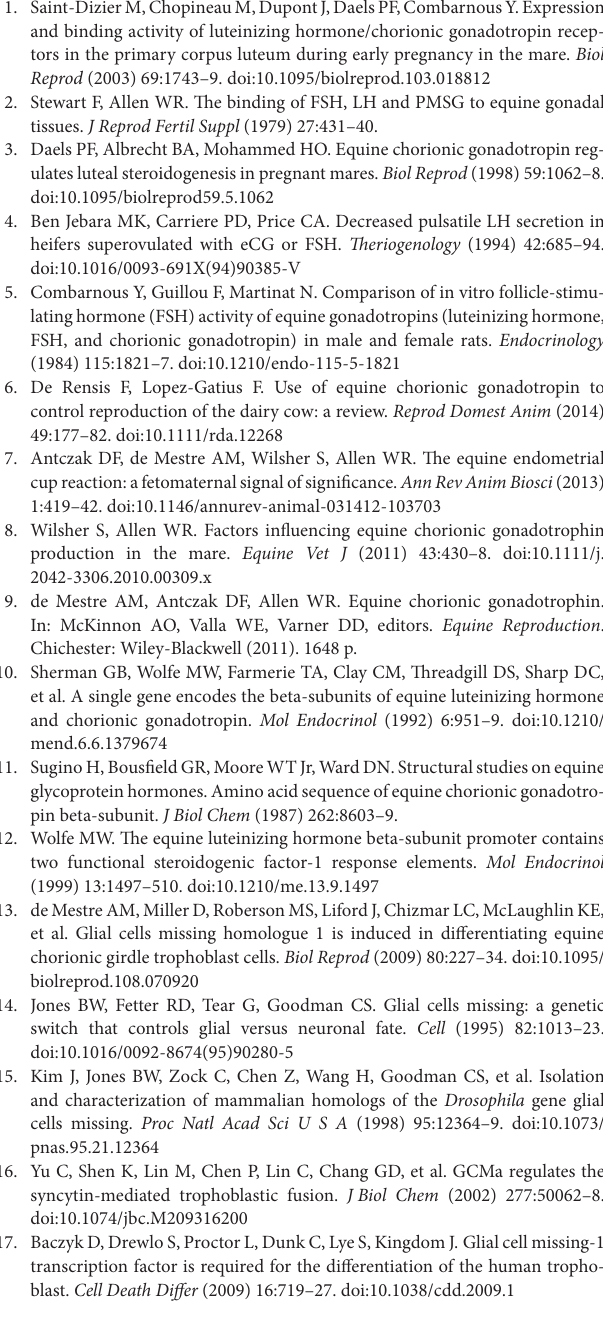
FigUre s3 | ChIP was carried out on formaldehyde fixed chromatin complexes from passage 1 day 34 primary chorionic girdle trophoblasts, using an antihuman glial cells missing 1 (GCM1) antibody for immunoprecipitation. Binding of GCM1 to predicted GCM1-binding sites was determined using PCR